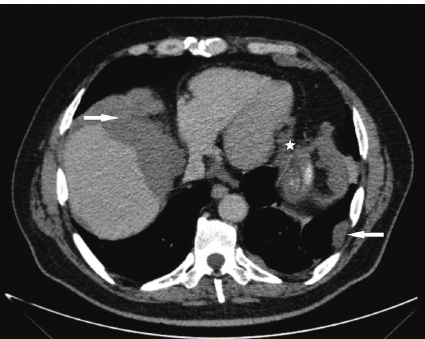
Figure 4: Metastatic nodules disseminated on pleural surfaces (arrows) and pericardial fat pads (star) are visualized by